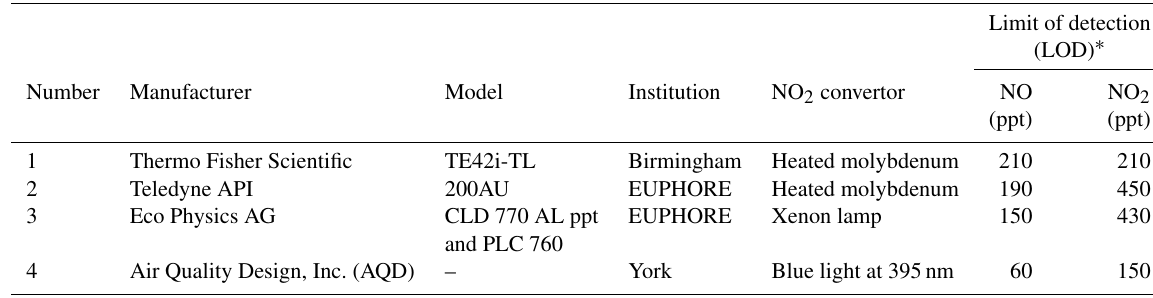
Table 1. Details of the NO x monitoring instruments used. Note: ppt – parts per trillion.